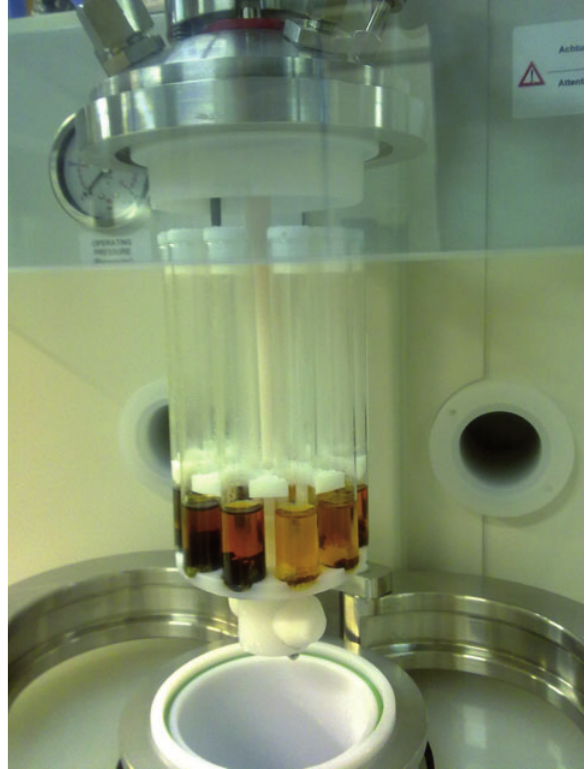
Figure 1 The rack with several test tubes in the MW reactor ( Synth WAVE